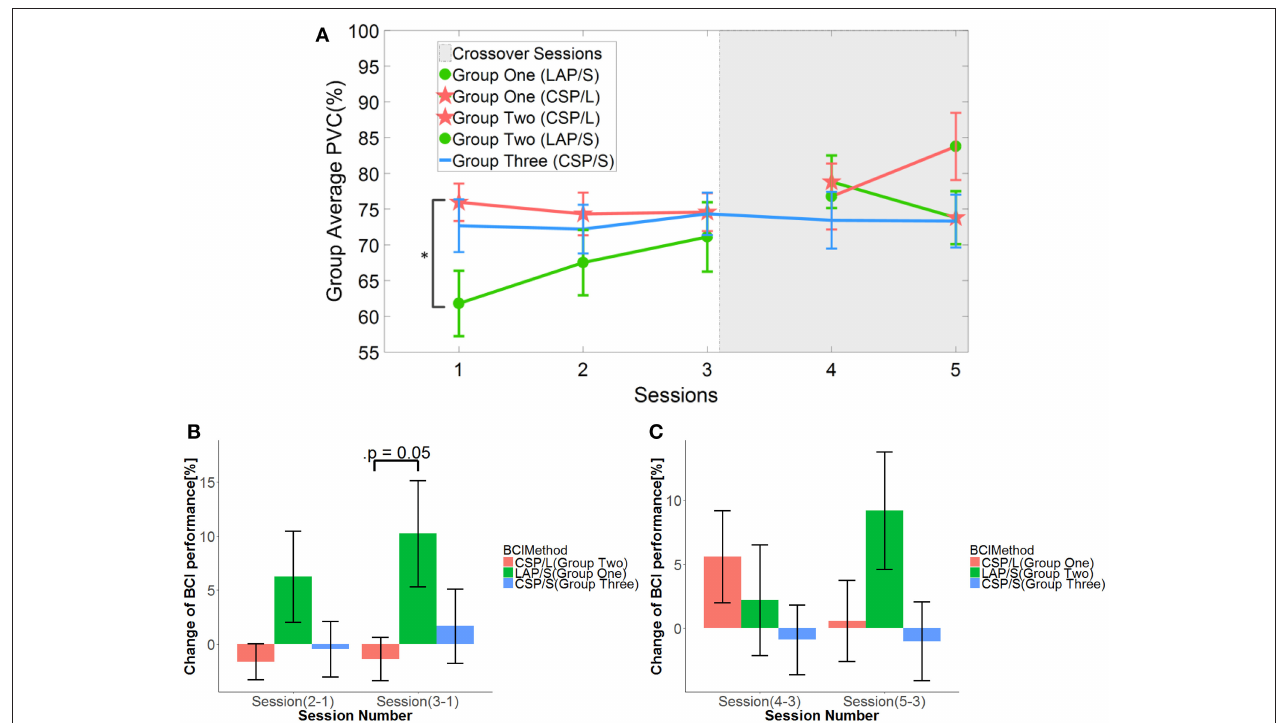
FIGURE 3 | Online BCI performance and statistical analysis results. (A) Online group average performance in terms of Percent Valid Correct (PVC) across all five sessions. The standard errors of the mean (S.E.M) are indicated by the error bars on each point along the three lines. The same group of participants is connected by the same color lines and the same method is marked by red star and green circle, respectively. The “*” indicates there is a significant difference of performance between LAP/S and CSP/L at the first session. (B) Change of BCI performance across the first three sessions relative to the first (baseline) session. A significant difference between the group using CSP/L and the group using LAP/S is apparent in the overall improvement of PVC from the first to third BCI session. (C) Change of BCI performance compared to the third (baseline) session after switching over